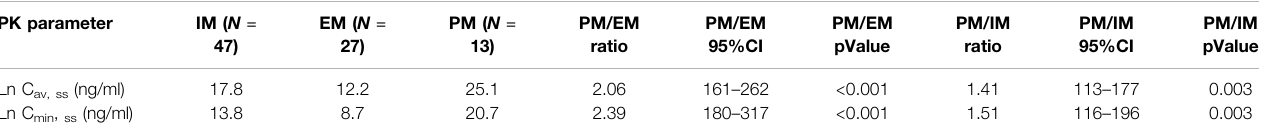
TABLE 5 | Comparison of C SS of different type of metabolizers.